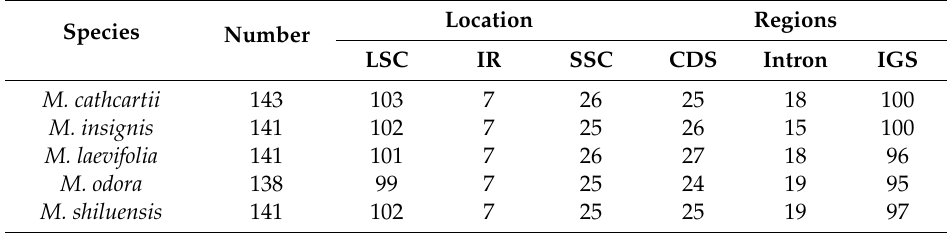
Figure 3. Single sequence repeats (SSRs) in the chloroplast genome of Michelia shiluensis . ( a ) Table 5. Distribution of single sequence repeats in different locations and regions among five Magnoliaceae Comparison of the SSRs among five Magnoliaceae species ( M. shiluensis , Michelia odora , Magnolia species: Michelia shiluensis , Michelia odora , Magnolia laevifolia , Magnolia insignis , and Magnolia cathcartii laevifolia , Magnolia insignis , and Magnolia cathcartii ); ( b ) base composition of SSRs in the cp genome of M. shiluensis .